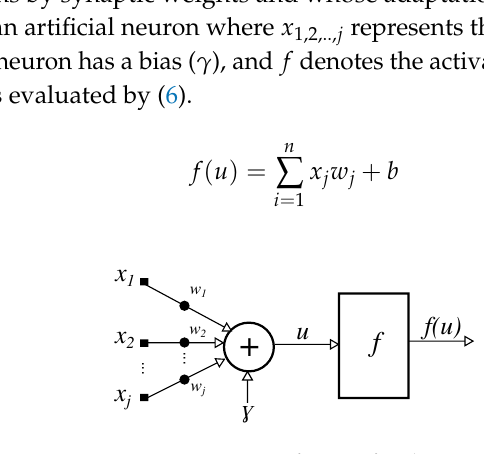
Figure 2. Structure of an artificial neuron.